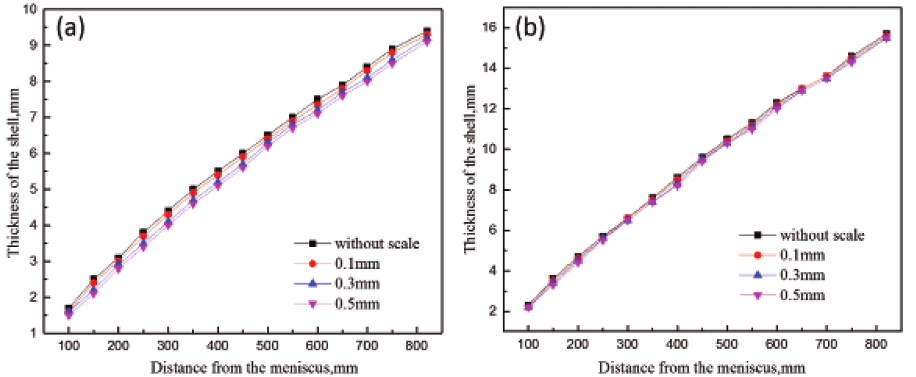
The 3D-NTI model can more accurately describe the temperature distribution in the mold than the 2D model. The highest temperature of the mold wall is 30 mm below the meniscus. The quality of the cooling water is critical for CC production because scale on copper will cause a sharp rise of the mold wall temperature. Upon increasing the scale thickness from 0 to 0.5 mm, a high-temperature area ( > 100°C) of the cold face of the mold wall appears and rapidly expands, which may cause boiling of the cooling water. In addition, the maximum temperature of the hot face of the mold increases from 174 °C to 364 °C (447 K to 673 K), which will lead to plastic deformation of the mold tube and aggravate stripping of the coating. (3) The shell thickness is slightly affected by the scale.